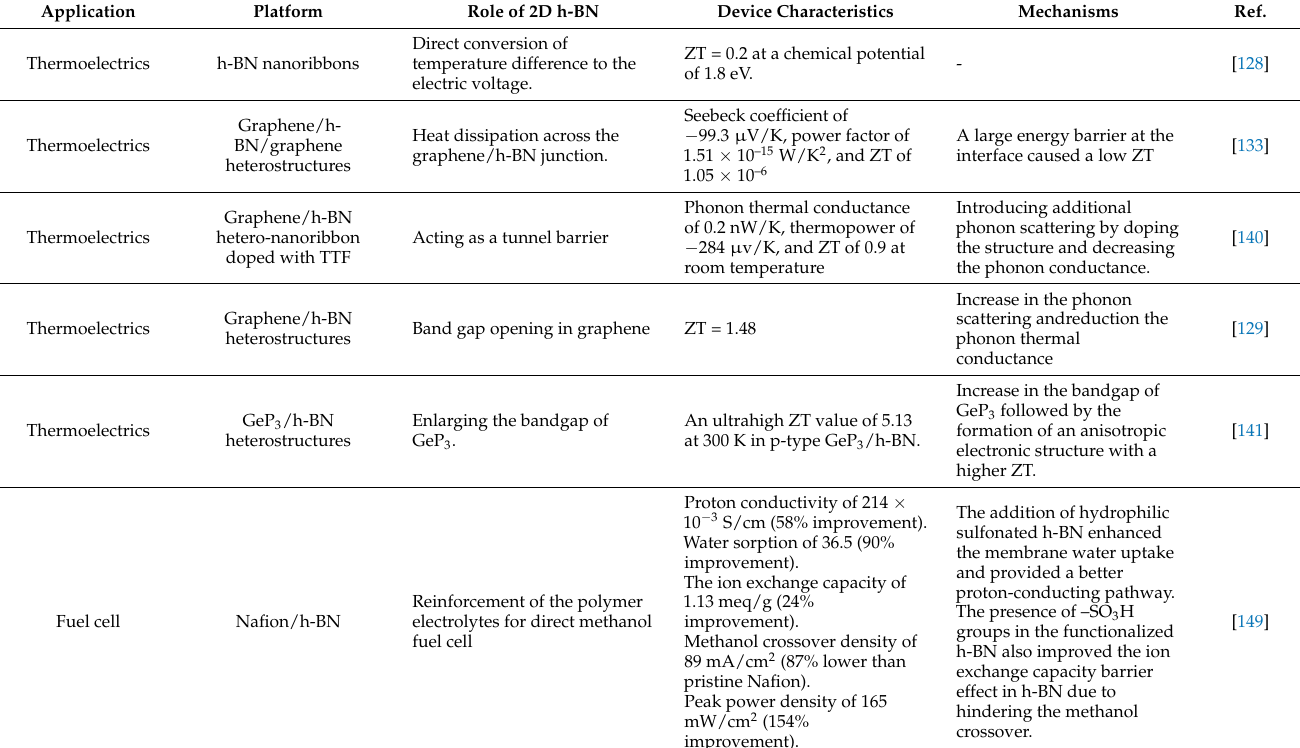
Table 3. Comparison of energy conversion device performance based on 2D